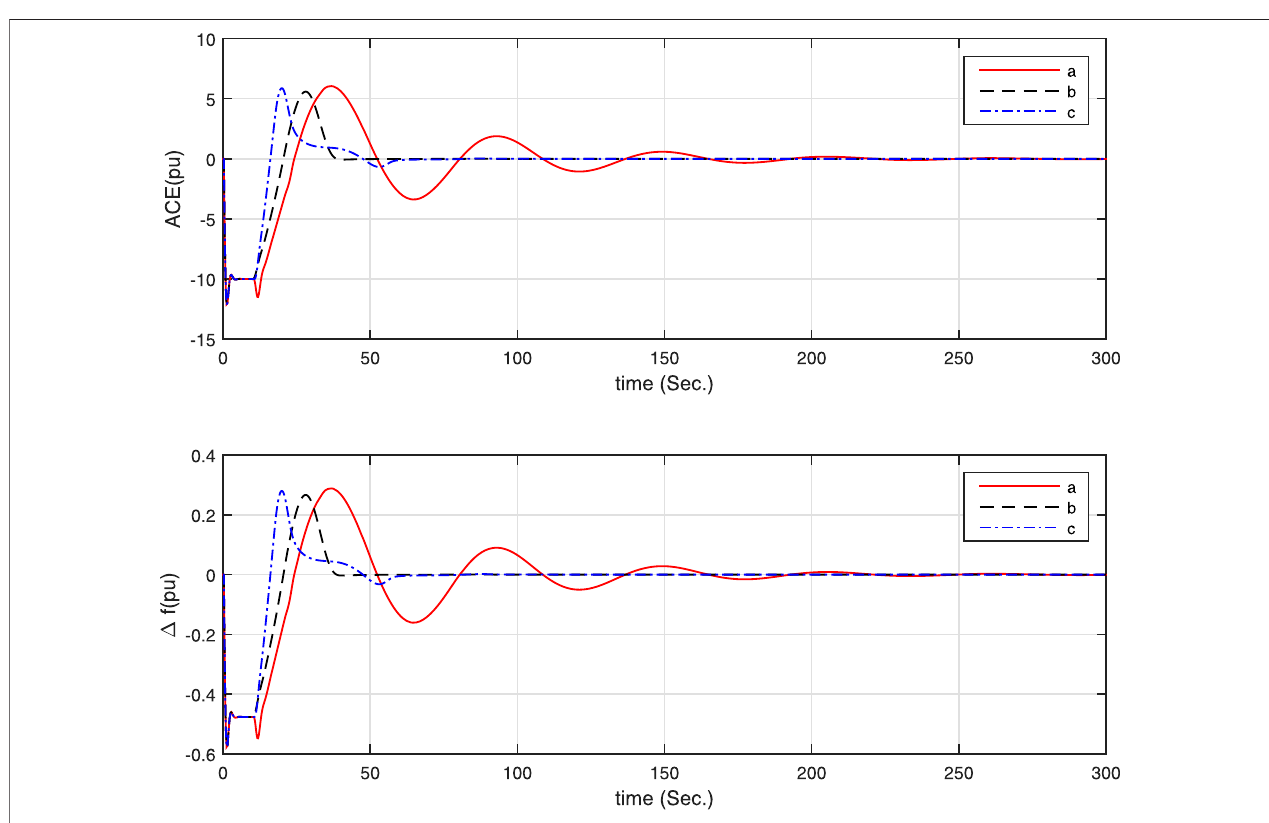
FIGURE 6 | Frequency deviation and control error responses of one-area LFC scheme under c (cid:2) 0.37.